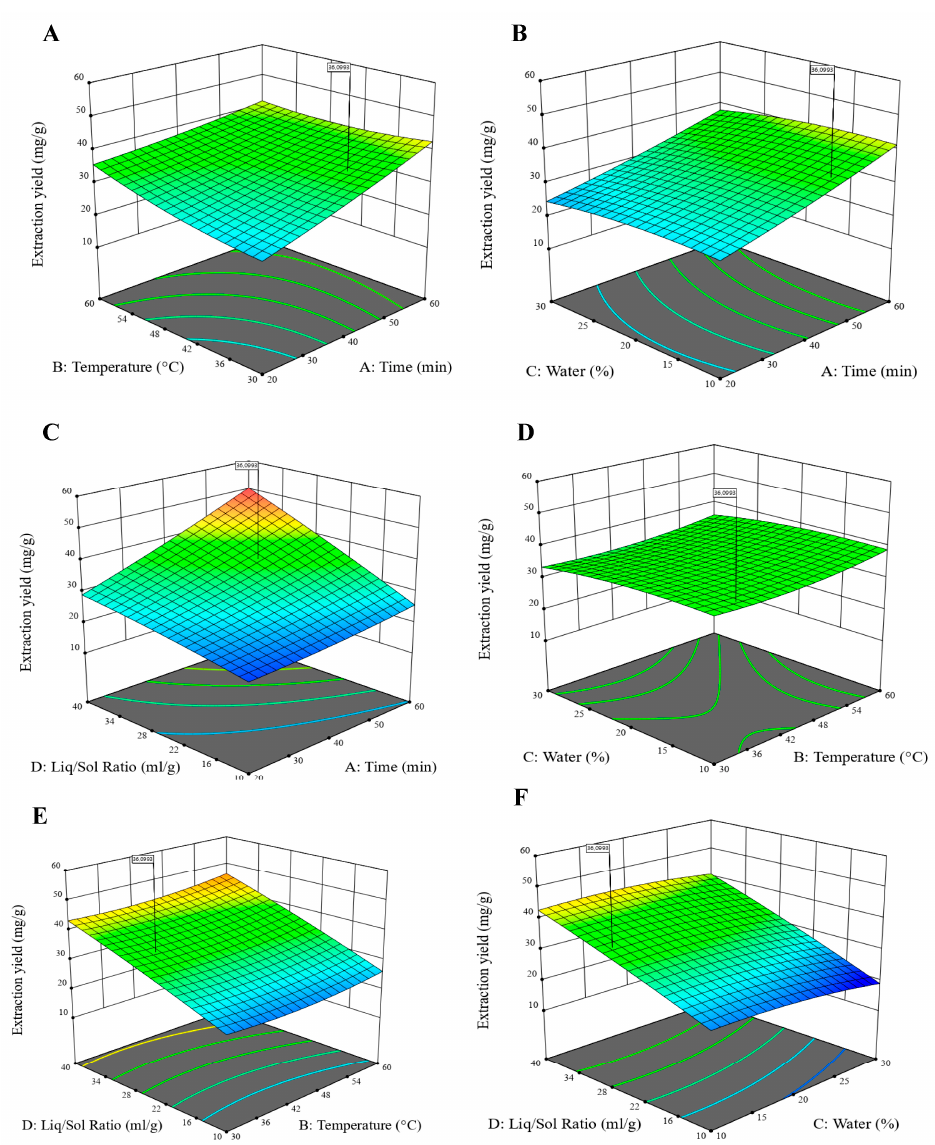
Figure 4. Response surfaces of piperine content for optimization. ( A ) Yield vs. water % and temperature; ( B ) Yield vs. water % and time; ( C ) Yield vs. Liq/sol and time; ( D ) Yield vs. water % and temperature; ( E ) Yield vs. Liq/sol and temperature; ( F ) Yield vs. Liq/sol and water %.